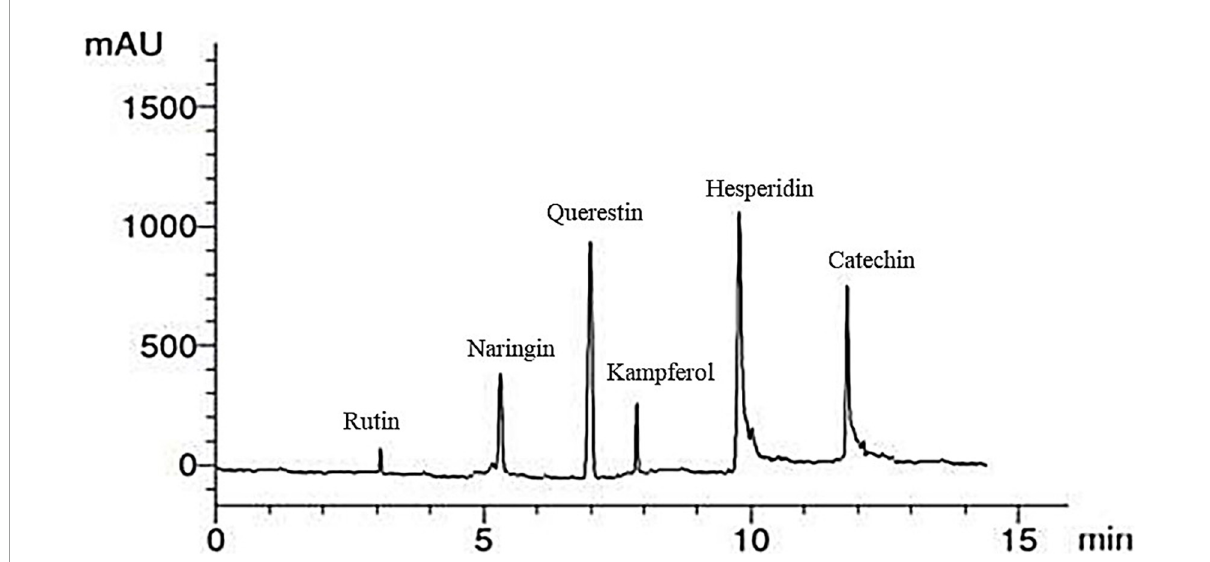
FIGURE3 High-performance liquid chromatography-chromatogram of major flavonoid compounds in red kidney bean seeds. mAU, milli-absorbance